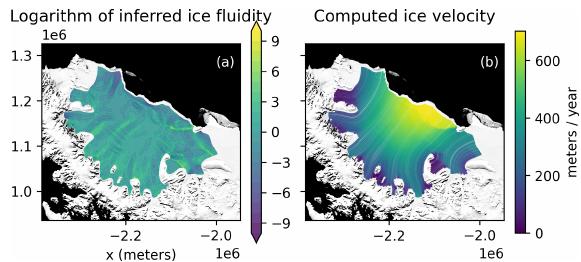
Figure 8. (a) Inferred fluidity parameter θ : higher values indicate more deformable ice. (b) Stream plot of ice velocity computed from this fluidity parameter. The background image is the MODIS Mo- saic of Antarctica (Scambos et al., 2007; Haran et al., 2014), cour- tesy of the NASA National Snow and Ice Data Center (NSIDC) Distributed Active Archive Center